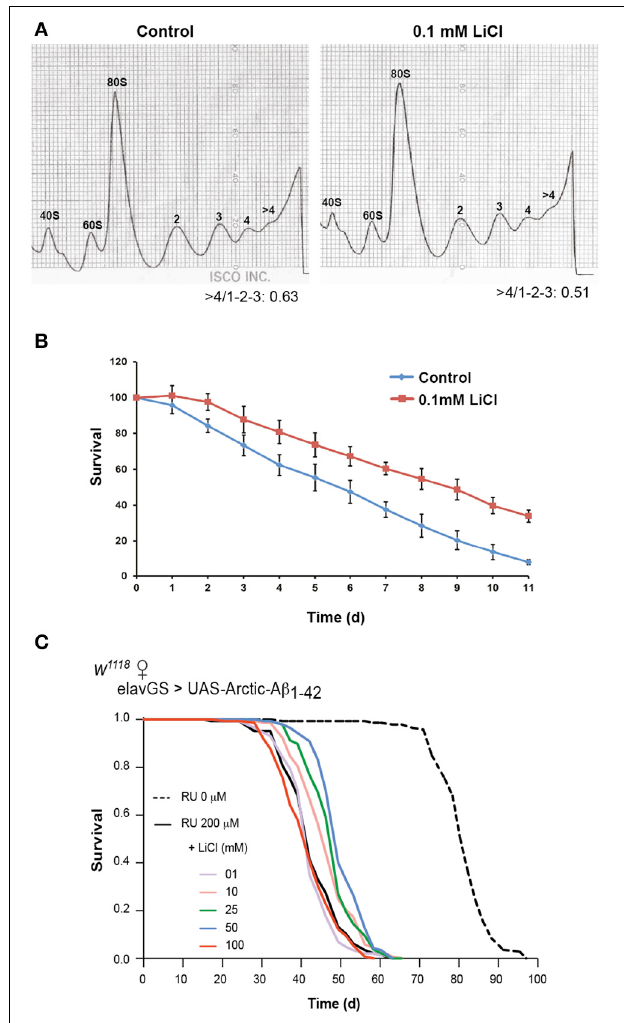
FIGURE 5 | Lithium reduced overall protein synthesis/translation and extended lifespan in fission yeast. (A) Polysome profiles showed a reduction in translation in lithium treated fission yeast cells. The area under the different fractions and their ratios were calculated (area under the first 3 peaks for low fraction, and > 4 for high, fraction, ratio > 4/1-2-3). Data were analyzed by paired t -test ( n = 3), P < 0.001. (B) 0.1mM LiCl increased the chronological median lifespan of fission yeast (paired t -test comparing triplicates of lifespan values at 50% survival/medial lifespan, P = 0 . 001). (C) Survival curves of flies expressing Arctic A β 42 with or without lithium treatment are depicted, data were compared using the log-rank test, comparing UAS-ArcA β 42/ + ;elavGS/ + + RU + LiCl 1, 10, 25, 50 or 100mM flies to UAS-ArcA β 42/ + ;elavGS/ + + RU controls. No significant difference was seen between UAS-ArcA β 42/ + ;elavGS/ + + RU controls and UAS-ArcA β 42/ + ;elavGS/ + + RU + LiCl 1 or 100mM, P = 0 . 24 and 0.17 respectively, a significant difference was observed with 10, 25, and 50mM LiCl, P < 0 .